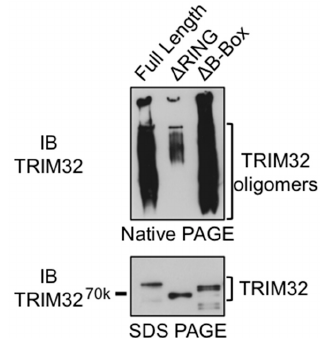
Figure 5. TRIM32 RING domain is necessary for oligomerization. Recombinant full-length TRIM32, ∆ RING, and ∆ B-box mutants were run on native PAGE (top panel) or in denaturing conditions (SDS-PAGE, bottom panel) and detected by anti-TRIM32 immunoblot.